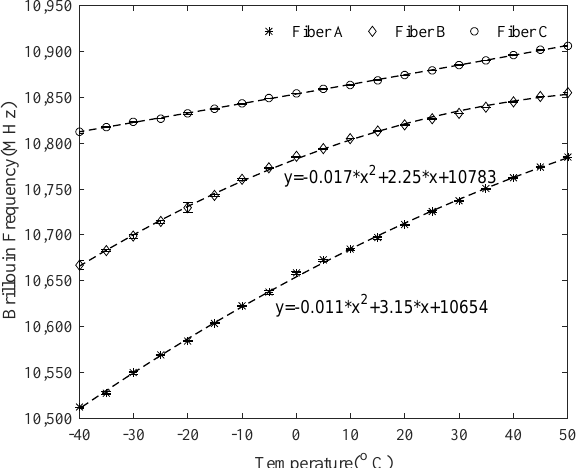
Figure 4. Brillouin frequency-shift variation with the temperature of three loose optical